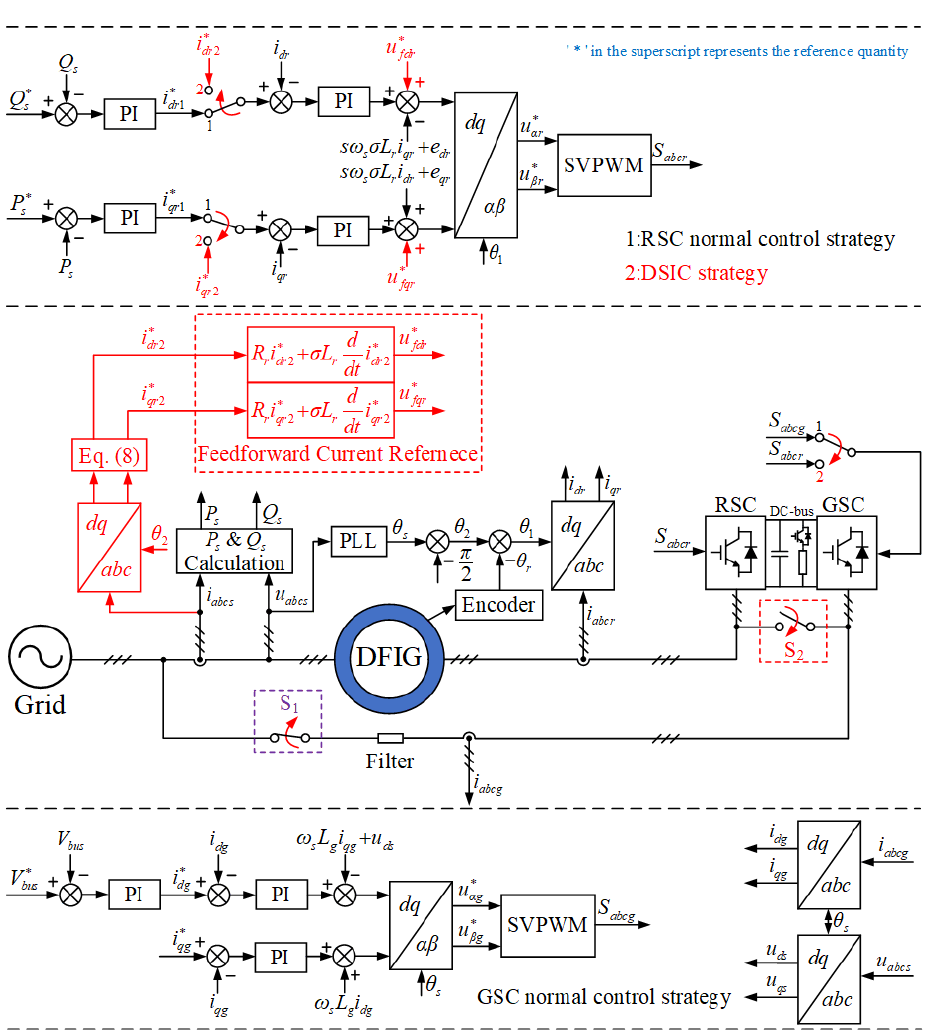
Figure 11. Schematic diagram of the DFIG control system with DISC strategy.